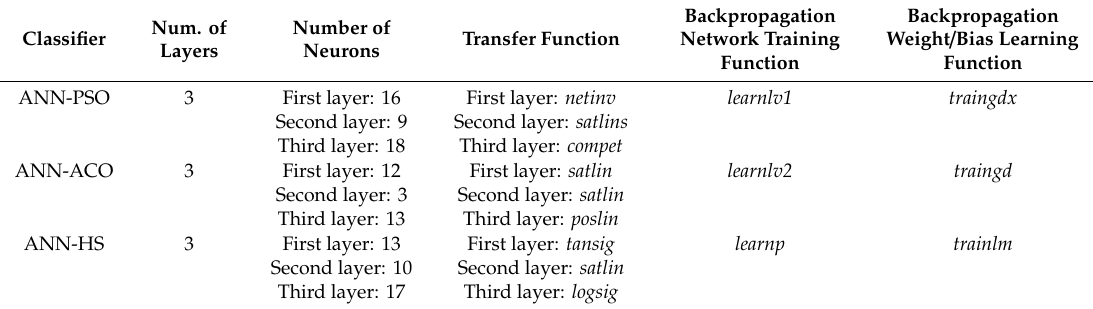
Table 4. Optimal architecture of hidden ANN layers determined by PSO, ACO and HS algorithms. [19]